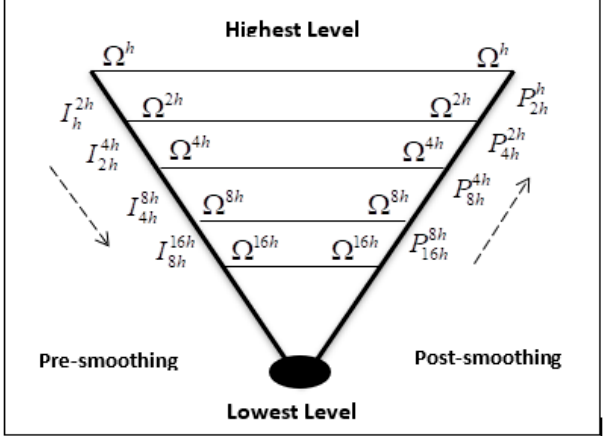
Figure 2. The V-cycle multigrid method.